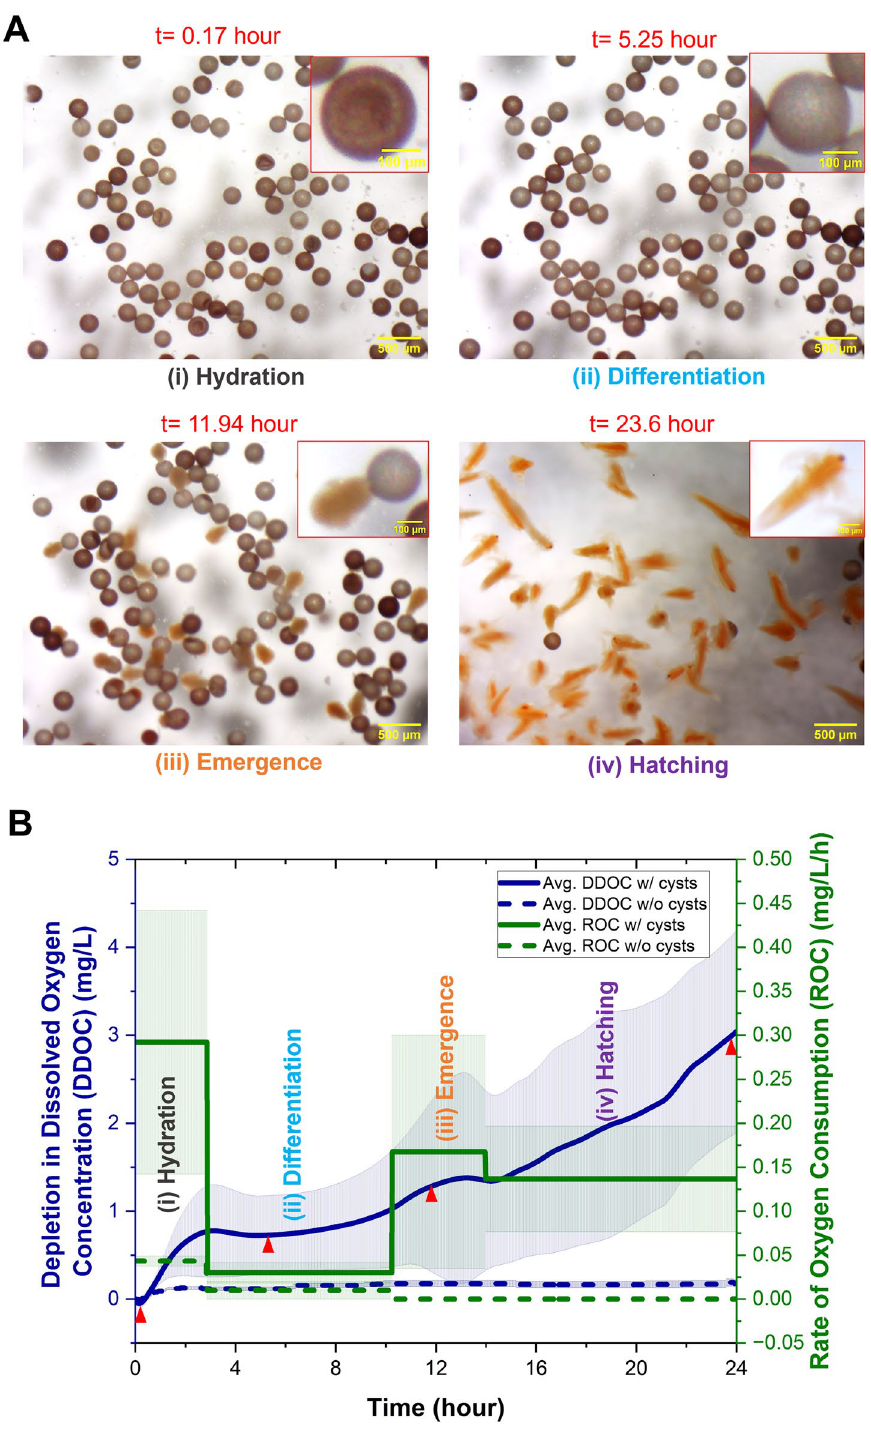
Figure 2. Photomicrographs and O 2 sensor readings at different stages of hatching. ( A ) Photomicrograph at different stages of hatching obtained from the optical stereomicroscope (scale bar = 500 µm). The inset shows the morphology of the cysts/nauplii at different stages (scale bar = 100 µm). ( B ) On-chip detection of the depletion in dissolved oxygen concentration (DDOC) when there were Artemia cysts (blue solid line) and no cysts (control-blue dashed line) in the hatching chip at 25 °C and 25 ppt. Rate of oxygen consumption (ROC) at different stages was represented by green lines (solid line- with cysts, dotted line-control). The bold lines in the graph show the average and the shaded area shows the standard deviation. Red triangles in ( B ) represent the DDOC at the time points corresponding to the photomicrographs presented in ( A